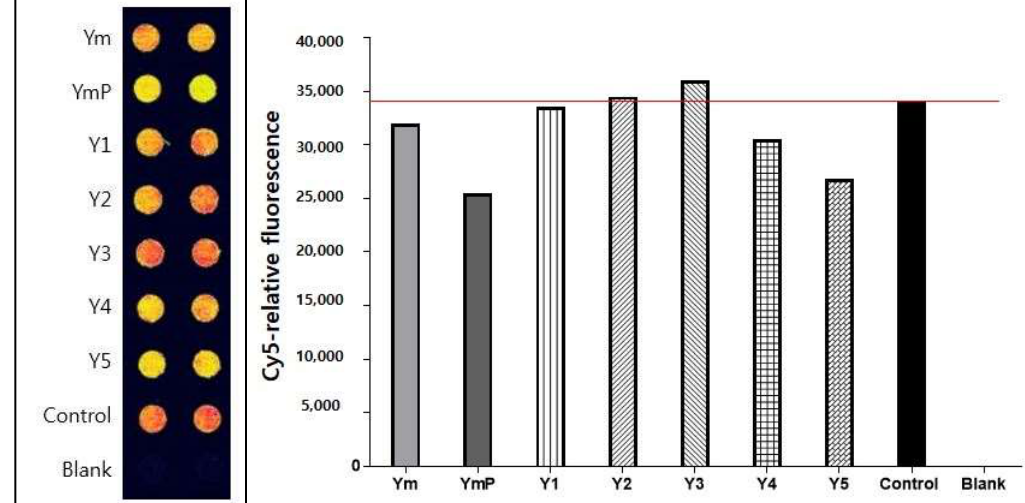
Figure 1. Screening of 5-HT2c receptor antagonists from modified Yukmijihwang-tang using protein chip-based 5-HT2cR assay. For screening effective antagonists to the 5-HT receptor, candidate drugs, including YmP, were reacted to a Protein Chip bound to 5-HT2c receptors, and then Cy5-tryptamine was added. In the case of YmP, the fluorescence signal was decreased, and YmP was an effective antagonist. Red color represents fluorescence intensity to Cy5-labeled tryptamine alone bound to 5HT2c receptors, and yellow color represents competitively drug-induced inhibitory binding activity. Concentration of 5-HT2cR is 50 μ g/mL and concentration of Cy5-labeled Tryptamine is 500 μ M. Yukmijihwang-tang (Ym); modified Yukmijihwang-tang (YmP), various modified forms of Yukmijihwang-tang (Y1-5).